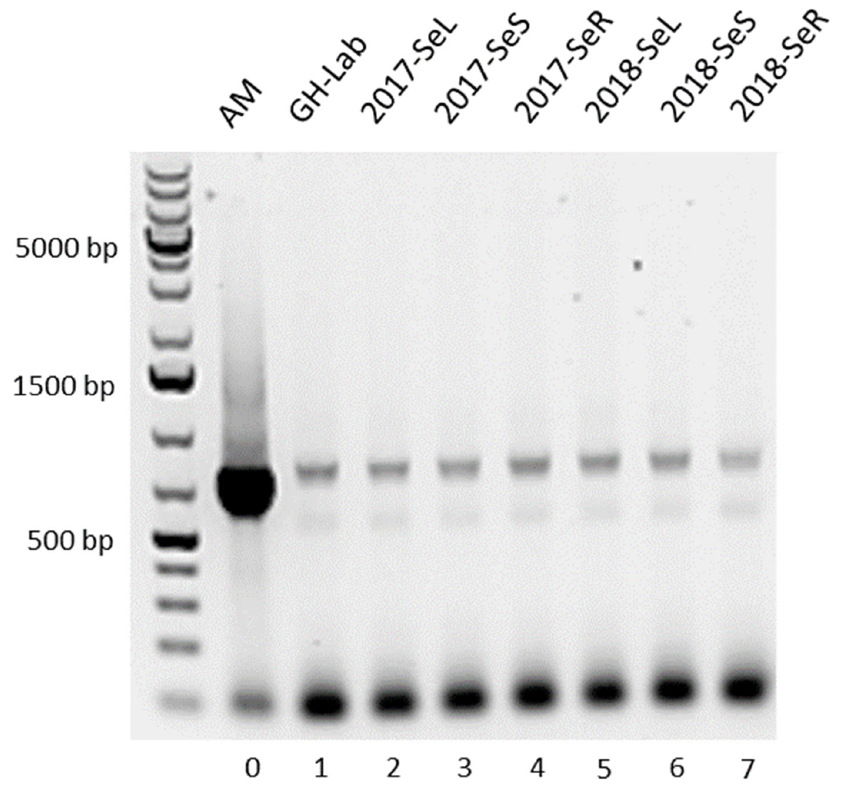
Figure 3. PCR products of the amplified AHBA synthase gene, spanning around 755 bp in different parts of 2017 and 2018 collections of G. heterophylla , originating from South Africa, compared to A. mirum (DSM 43827) as the reference. Our reference, A. mirum (AM), is indicated by 0, while 1 indicates the aerial part of G. heterophylla cultivated at our laboratory in Germany (GH-Lab). Furthermore, 2 to 4 indicate the leaves, stems, and roots of the 2017 collection of G. heterophylla , originating from South Africa (2017-SeL, 2017-SeS, and 2017-SeR), while 5 to 7 indicate the counterpart from the 2018 collection (2018-SeL, 2018-SeS, and 2018-SeR).